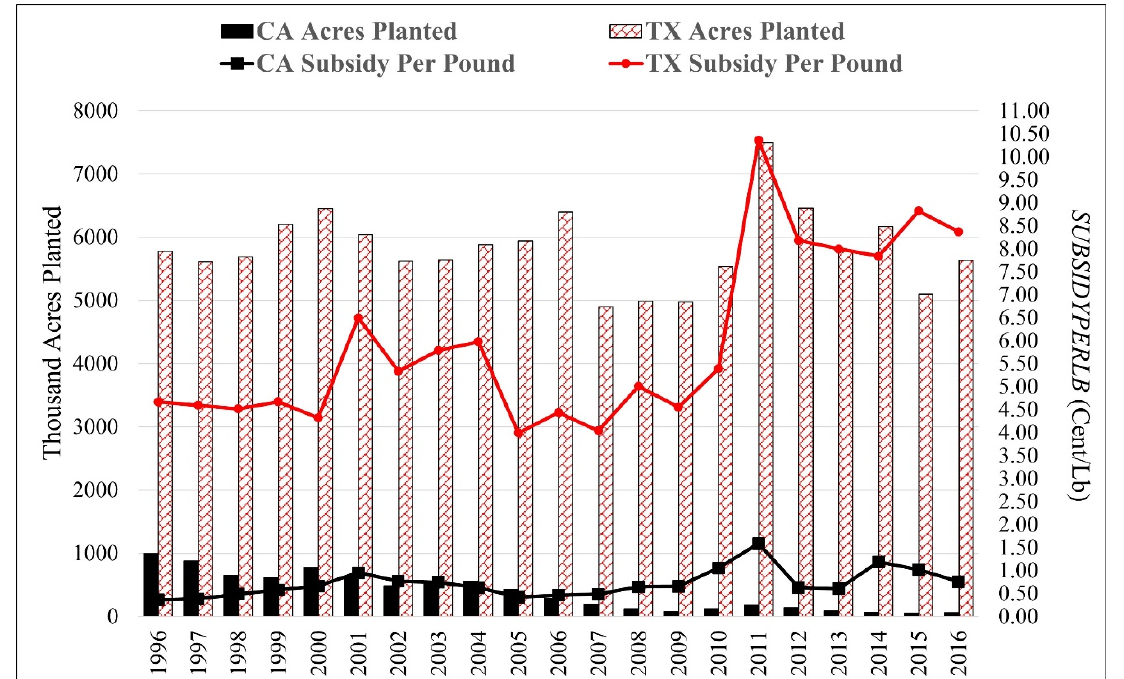
Figure 1. Expected premium subsidy per pound of production ( SUBSIDYPERLB ) and acres of upland cotton planted for California and Texas, 1996–2016.